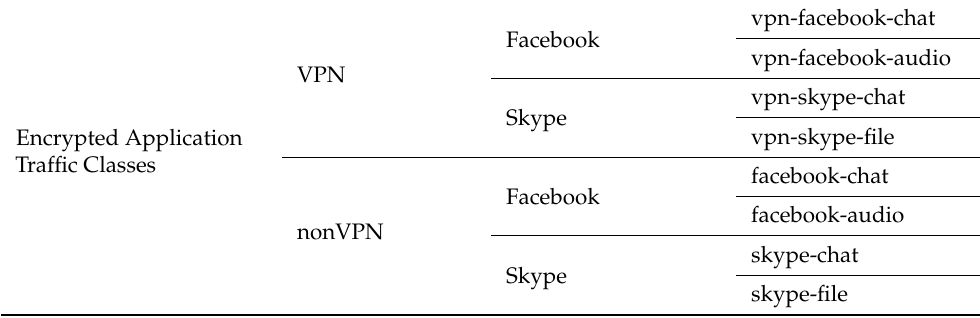
Table 1. Data classes of encrypted